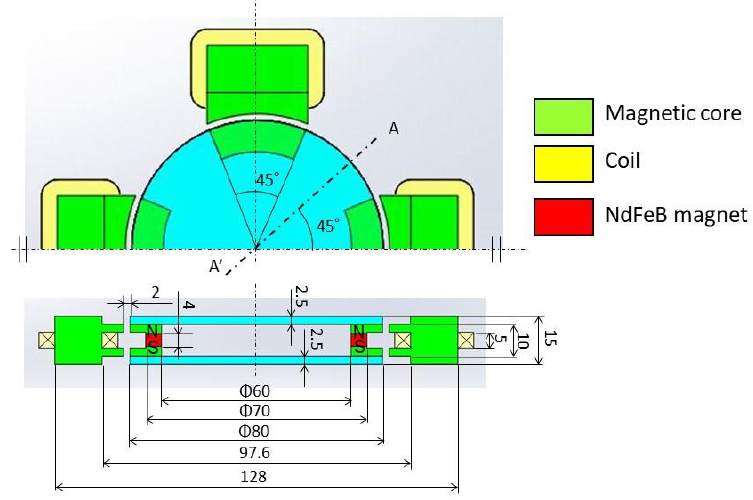
Figure 7. The design and the dimensions of the magnetic suspension mechanism.